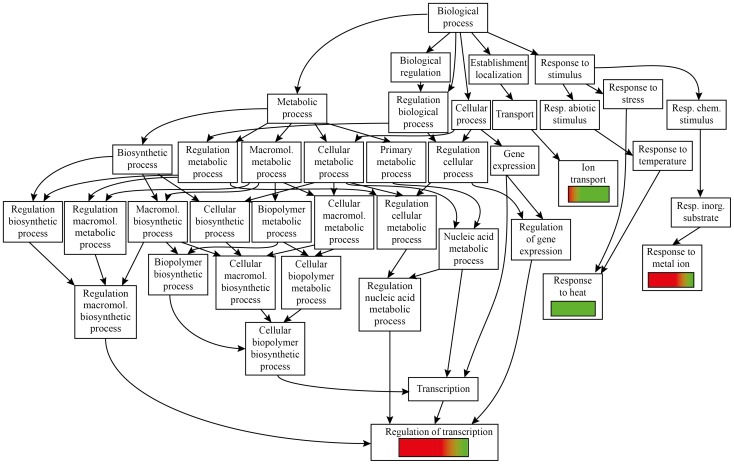
GO analysis of Arabidopsis genes regulated by Spodoptera littoralis herbivory.Red color indicates up-regulation, green color indicates down-regulation.